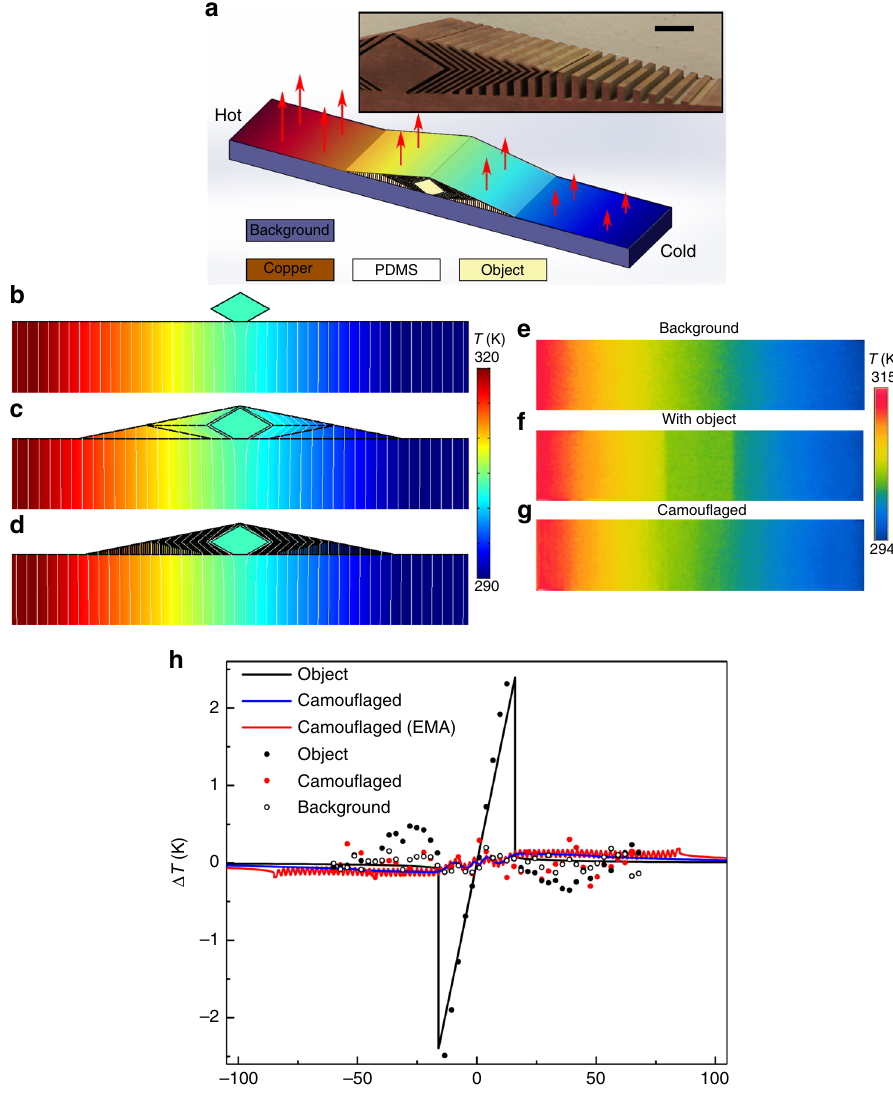
Fig. 3 Simulated and experimental results of the thermal radiation camou fl age. a Scheme of the simulations and experiments. The colour contour on the top surface of the device represents a temperature gradient. The inset shows a photo of the sample used in the experiments (without the PVC cover and the PDMS fi ller), where the scale bar is 1 cm. b – d Simulated temperature distributions for b an object, camou fl aging device built with c an anisotropic material and with d an effective medium approximated (EMA) structure. The black lines are boundaries for different thermal conductivities. The white lines are isothermal lines. Experimentally measured temperature pro fi les for e a pure background, f a background with an object on the surface, and g a background with an object on the surface that is camou fl aged by the structured thermal surface. h Surface temperature deviation Δ T from the theoretical solution for a pure background. Lines are calculated from the simulated surface temperature distributions for each case. The markers are calculated from the surface temperatures data points gathered by the IR camera and averaged in the y